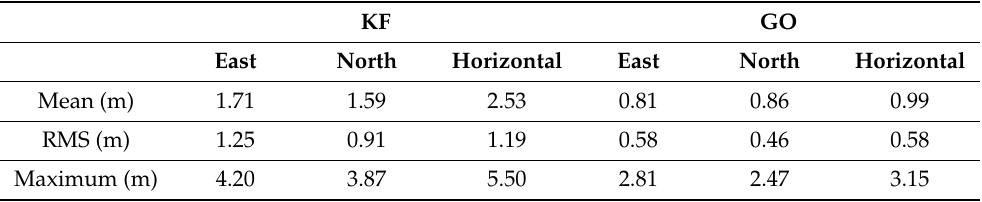
Table 2. Latitude position errors analysis and